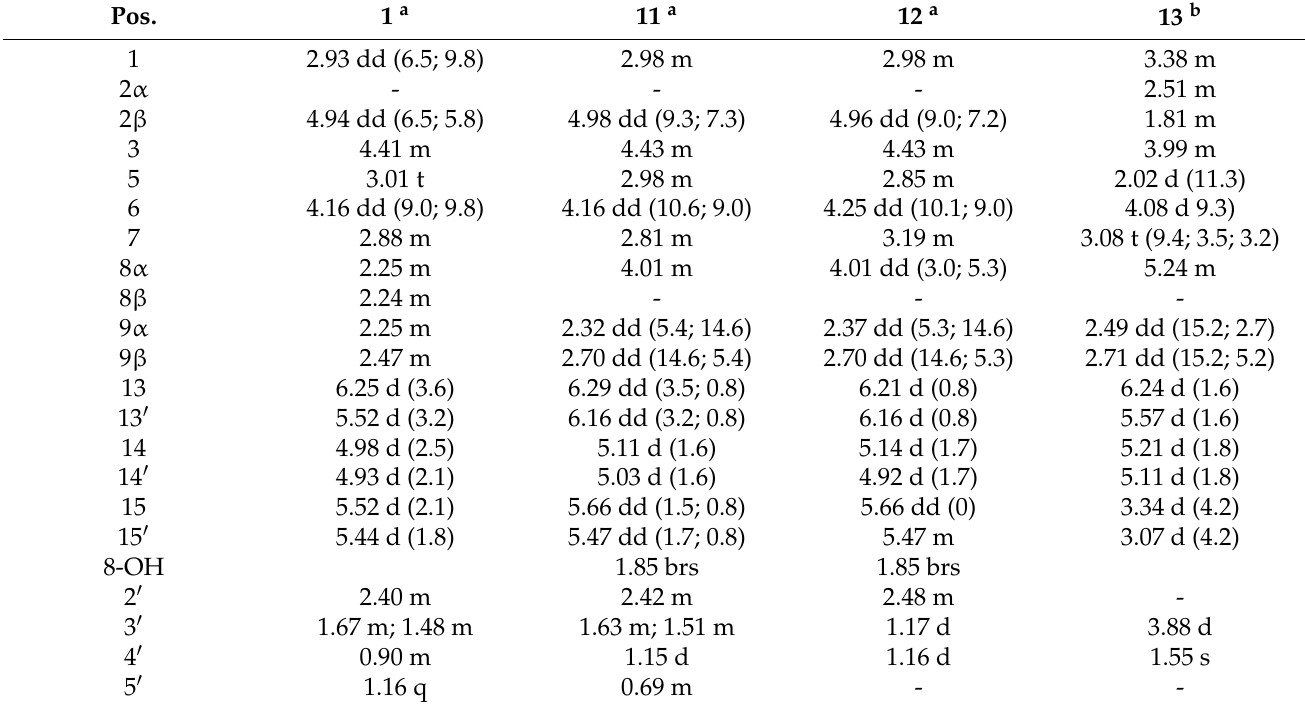
Table 1. 1 H NMR (600 MHz) spectroscopic data ( δ H in ppm, mult; J in Hz) of compounds: 1 and 11–13 .